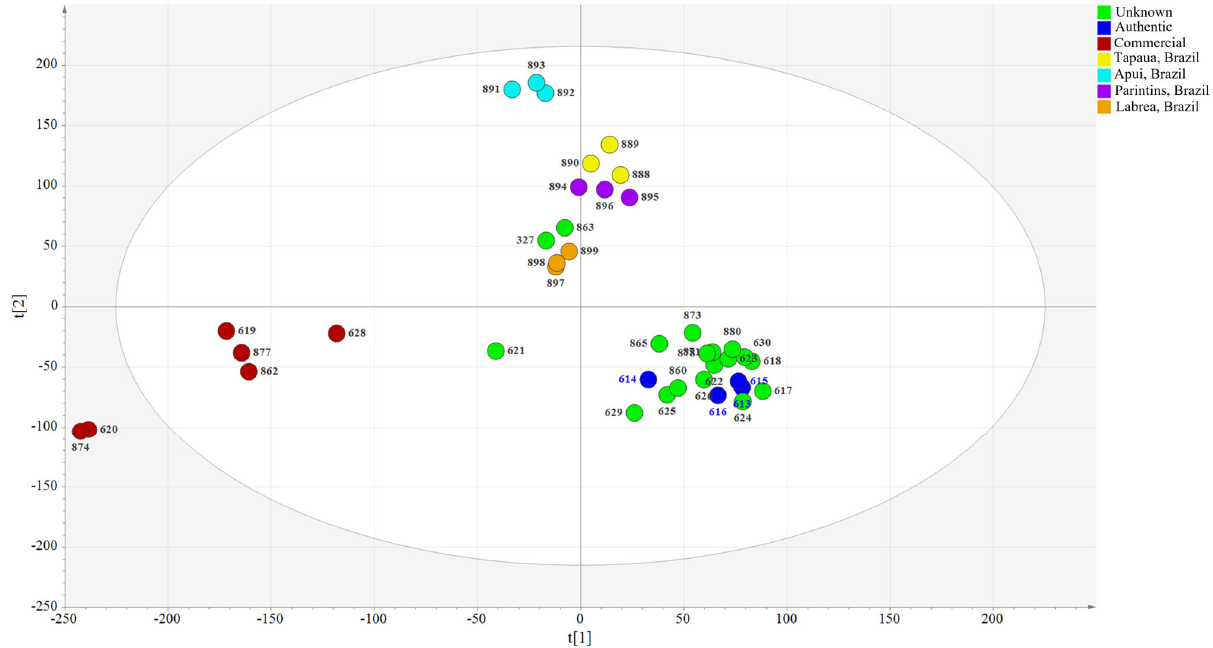
Figure 4. PCA score plot of all the samples.